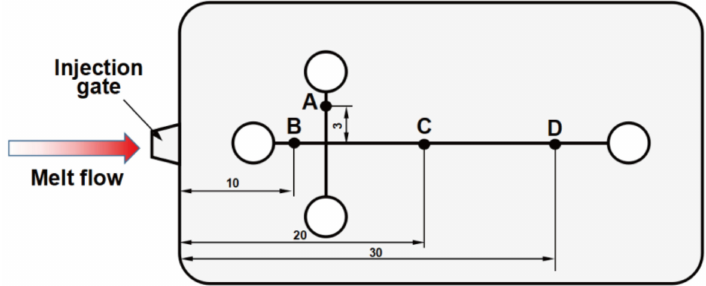
Figure 3. The distribution of the detection positions (A, B, C, D) in the substrate sheet (unit: